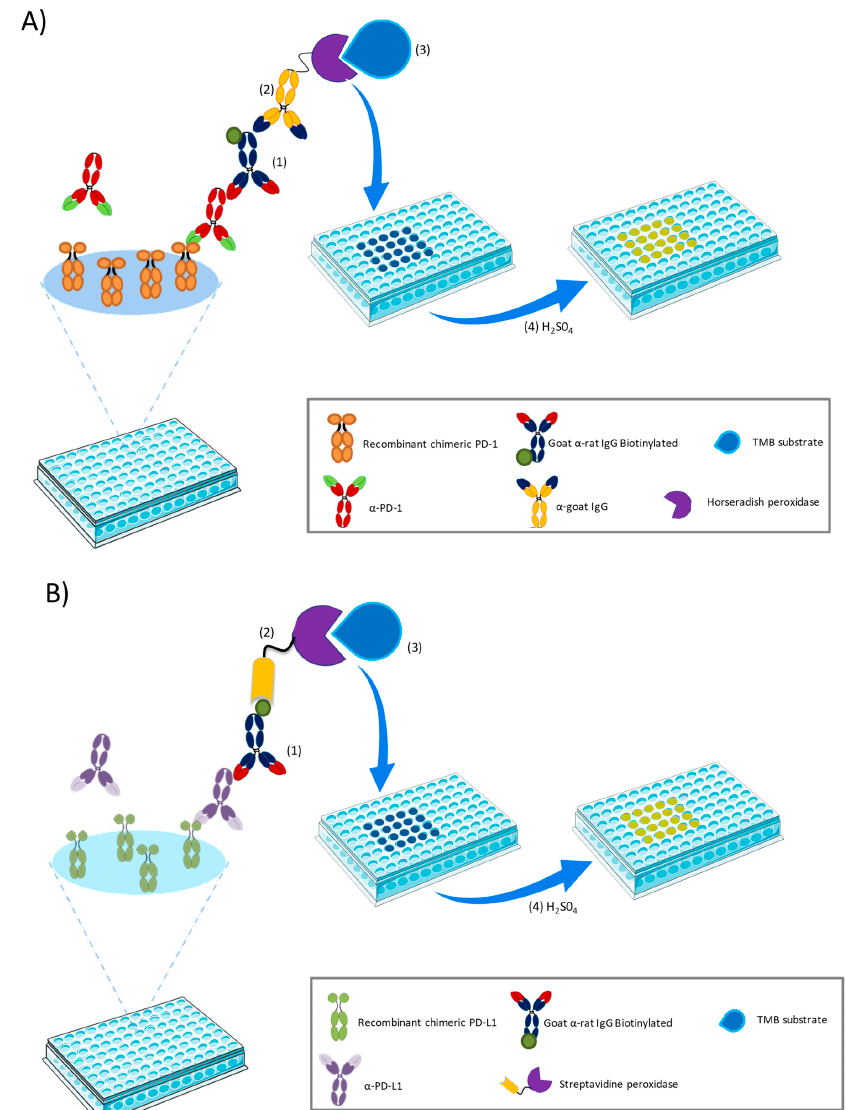
Figure 2. Schematic representation of the sandwich ELISA developed and validated in the present work. ( A ) ELISA to quantify a-PD-1 in plasma; numbers correspond to the consecutive steps: (1) addition of secondary goat α -rat IgG, (2) incubation with α -goat IgG HRP-conjugated antibody, (3) incorporation of TMB substrate, (4) stopping of the reaction with H 2 SO 4 . ( B ) ELISA to detect a-PD-L1 in plasma;numbers correspond to the different steps of the ELISA: (1) addition of secondary goat α -rat IgG biotin conjugate, (2) incubation with streptavidin-peroxidase, (3) incorporation of TMB substrate, (4) stopping of the reaction with H 2 SO 4 .